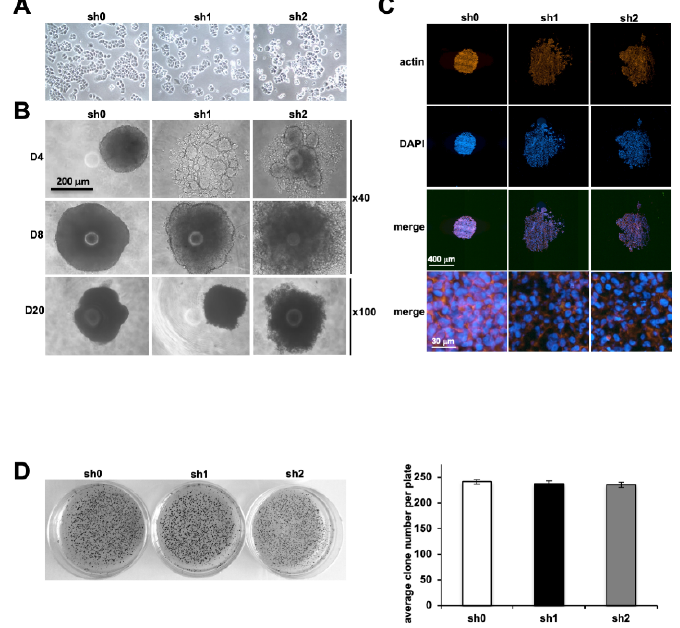
Figure 3. Effect of Stau1 depletion on tumor formation. ( A ) Representative pictures of sh0, sh1 and sh2 cell lines in 2D culture. Stau1 depletion has no visible impact. ( B ) Representative pictures of sh0, sh1 and sh2 cell lines on tumor spheroid formation at days 4, 8 and 20. Stau1 depletion prevents the formation of compact spheroid tumors in sh1 and sh2 cell lines. ( C ) Cross-sections were performed on spheroids. Actin cytoskeleton was evaluated and nuclei stained with DAPI. ( D ) Colony assay formation. Colonies were stained with MTT (left). Quantification did not reveal any significant difference between all three cell lines (right). Stau1 does not interfere with H460 cells’ capacities to form colonies.